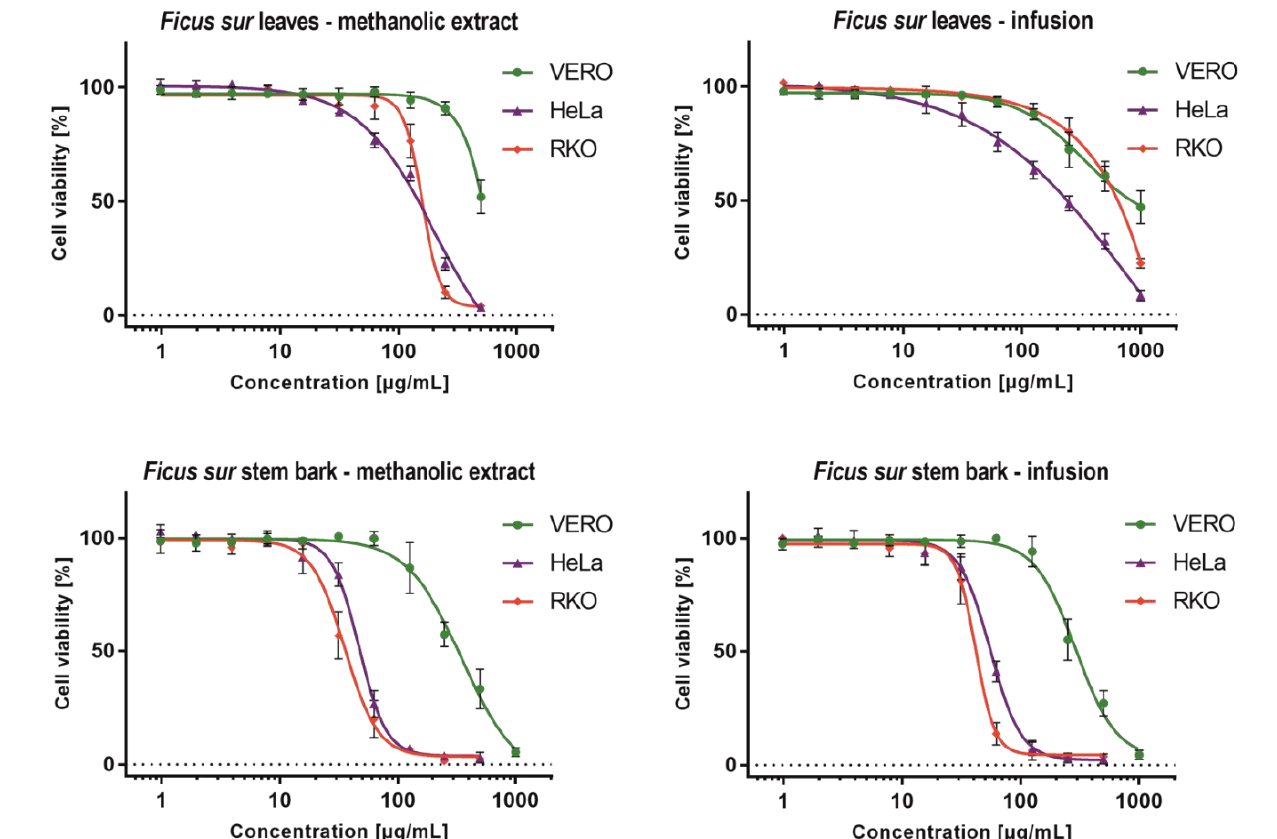
Figure 2. Influence of Ficus sur extracts on normal and cancer cells . Table 5. Results of cytotoxicity evaluation .